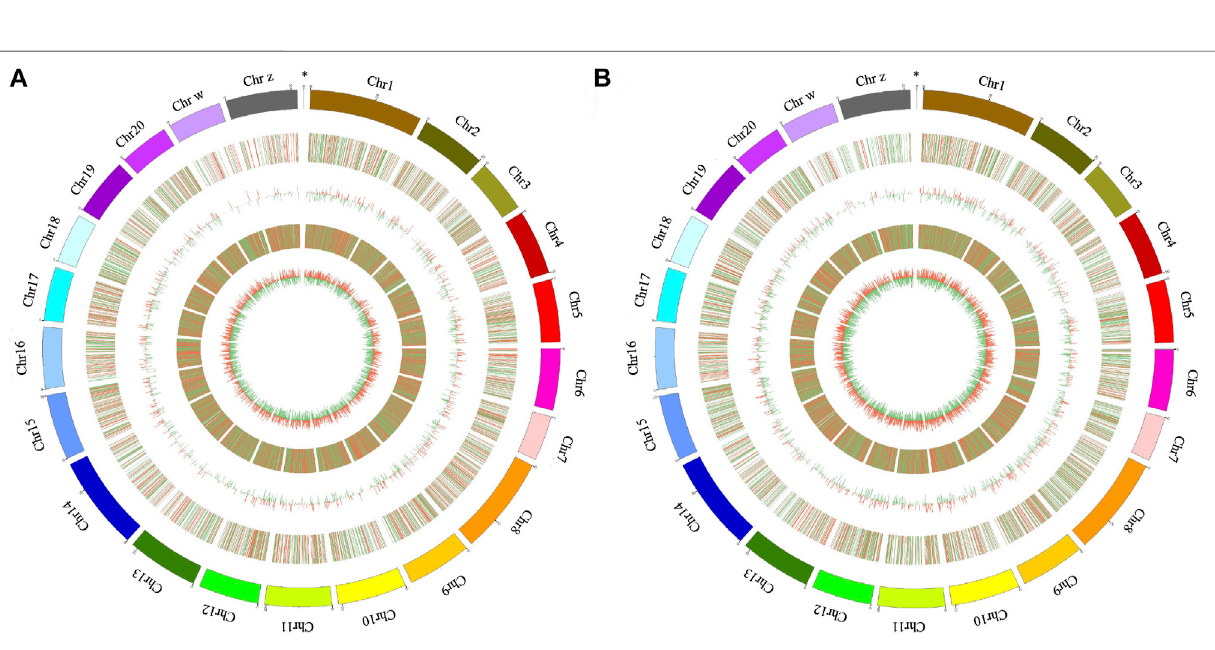
187 downregulated, in the ovarian stages V vs. VI comparison group. There were 6 DE lncRNAs were identi fi ed in both comparison groups (stages IV vs. V and V vs. VI) ( Supplementary Table S4 , Figure 2B ).